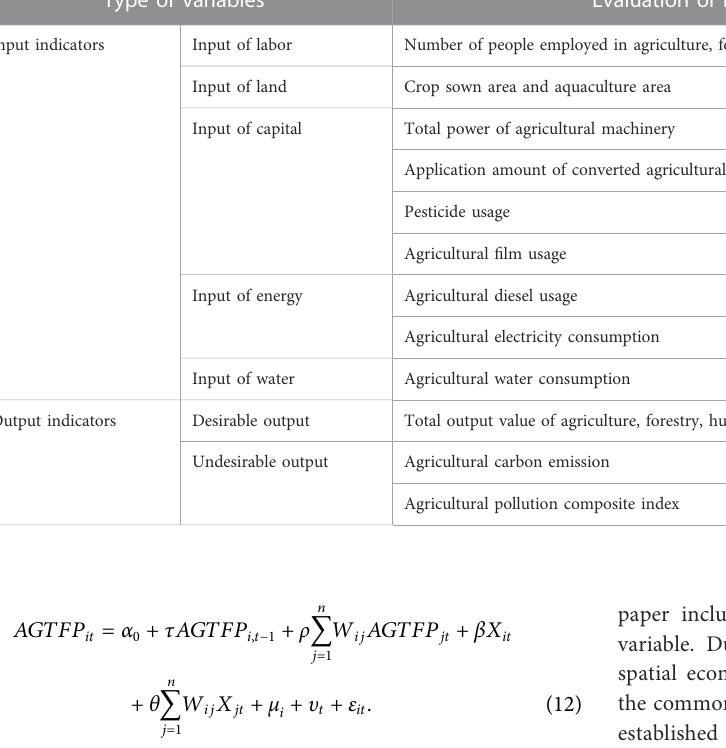
TABLE 1 Measuring indicators of AGTFP. Type of